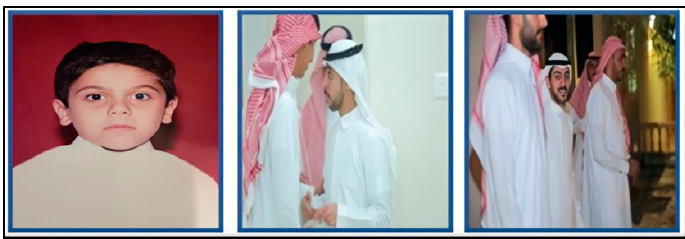
Figure 19. Samples of recognized different age stages of one person.